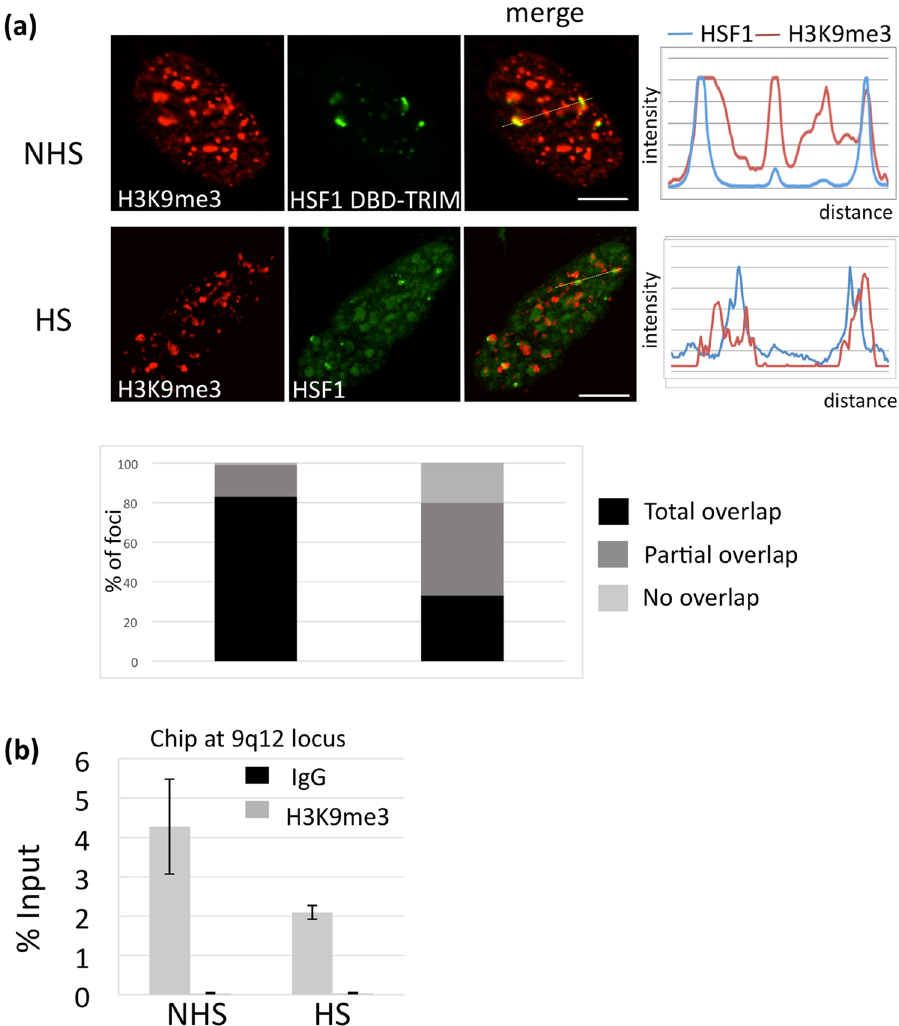
endogenous HSF1 (green signals). In stressed cells, a higher percentage of foci displaying no overlap or a partial overlap of HSF1 (green signals) and H3K9me3 (red signals) fluorescence profiles is observed. Percentages were obtained from a total of 300 nSB profiles (Barr = 5 µ m). ( b ) Evolution of H3K9me3 at the 9q12 locus determined by ChIP in HeLa unstressed (NHS) and stressed (HS)